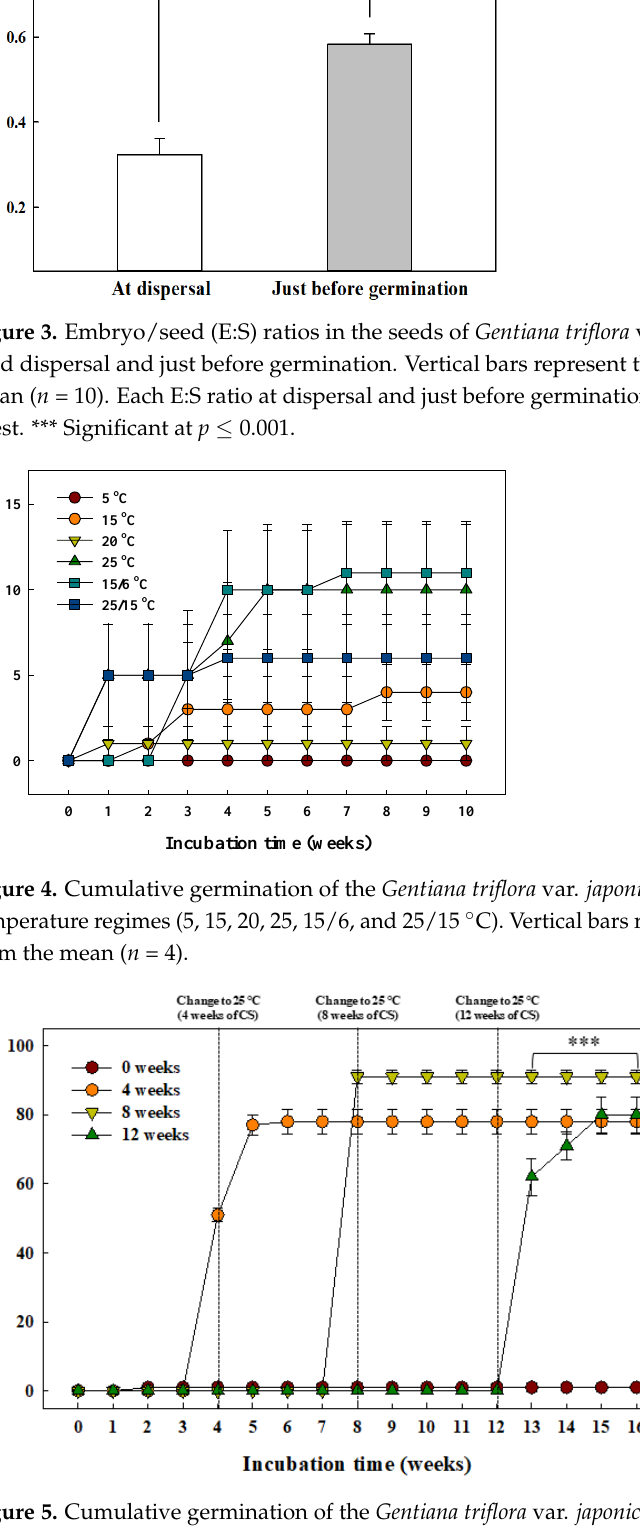
Figure 3. Embryo/seed (E:S) ratios in the seeds of Gentiana triflora var. japonica (Kusn.) H. Hara at seed dispersal and just before germination. Vertical bars represent the standard deviation from the mean ( n = 10). Each E:S ratio at dispersal and just before germination was compared using a paired t -test. *** Significant at p ≤ 0.001.